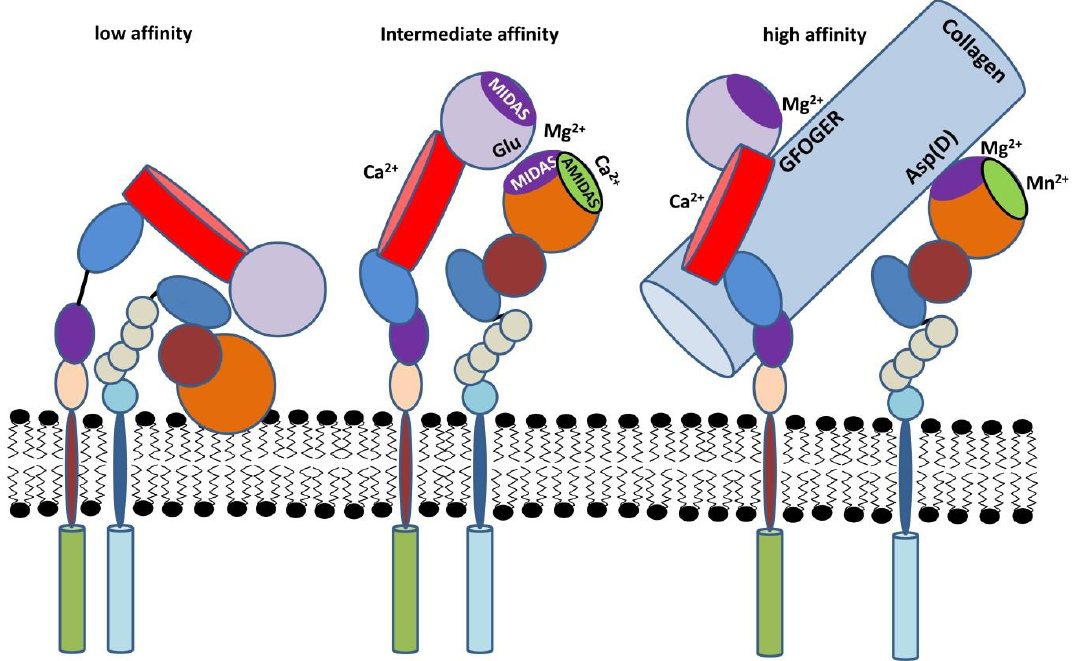
Figure 3. Conformational alterations determine the conformation and thereby the binding affinities of β 2 integrins.